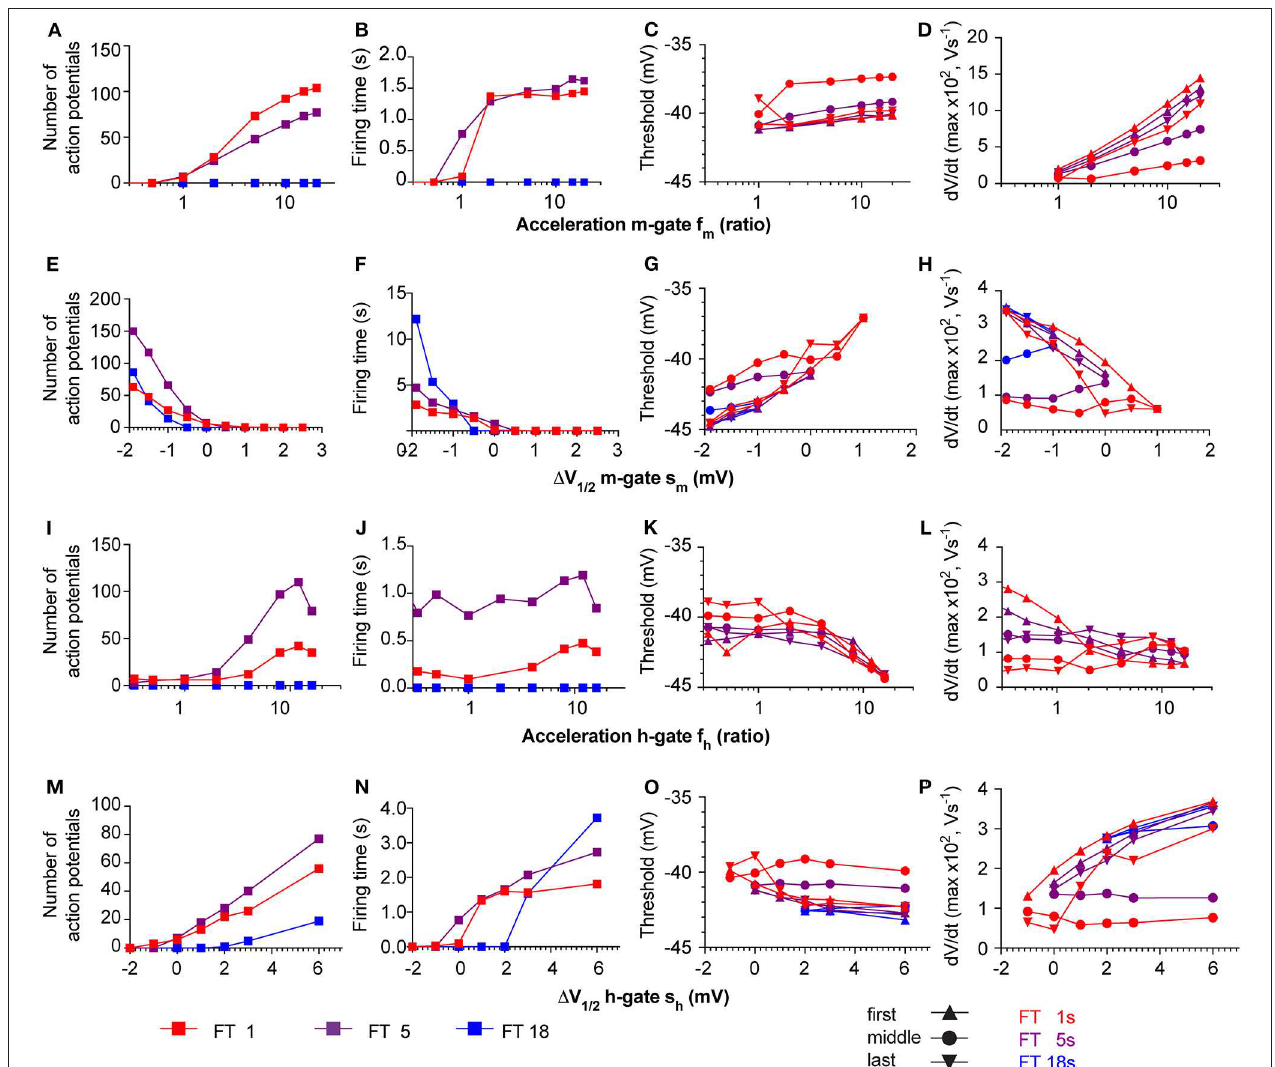
FIGURE 11 | Responses of the neuronal models to variations of Na v parameters. The neuronal modeling results are summarized for pH ramps of three durations [short, FT ( = fall time) 1s; intermediate (FT 5s); slow (FT 18s)], and in which the following Na v parameters were varied: Kinetics of the m-gate, f m (A–D) , shift of the V 1 / 2 of the m-gate, s m (E–H) , kinetics of the h-gate, f h (I–L) , and shift of the V 1 / 2 of the h-gate, s h (M–P) . The responses are shown in terms of number of APs (1st column from left), firing time (2nd column from left), and two parameters from phase-plane plot analysis of the first, middle and last AP in the burst, the spike threshold (3rd column from left) and the maximal AP upstroke velocity (1st column from right). The colors of the symbols refer to the speed of the pH ramp, and the symbol types in the two right columns refer to the position of the studied AP within the burst, as indicated in the